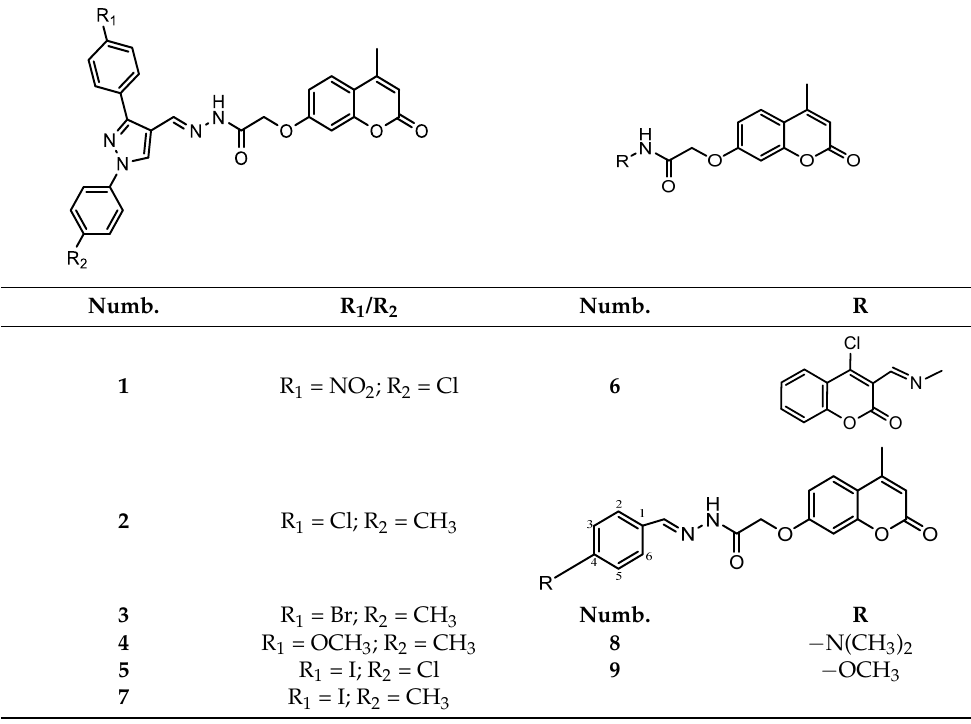
Table 1. Structures of the analyzed coumarinyl Schiff bases.